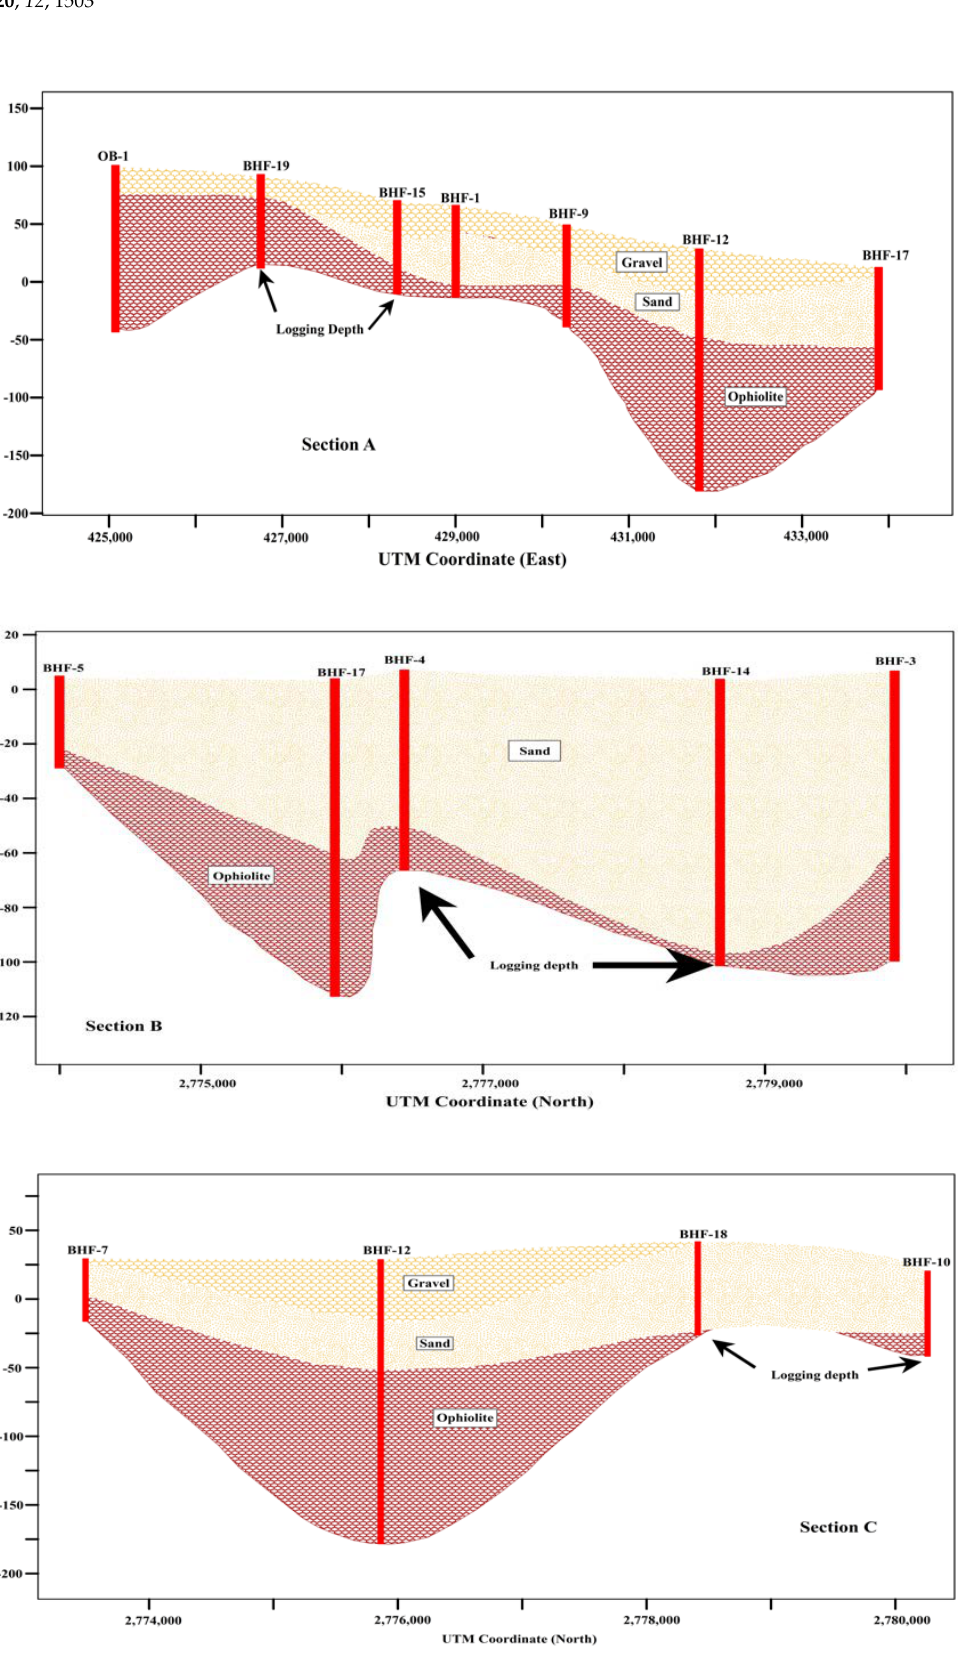
Figure 4. Several geological cross-sections across Wadi Ham [28].